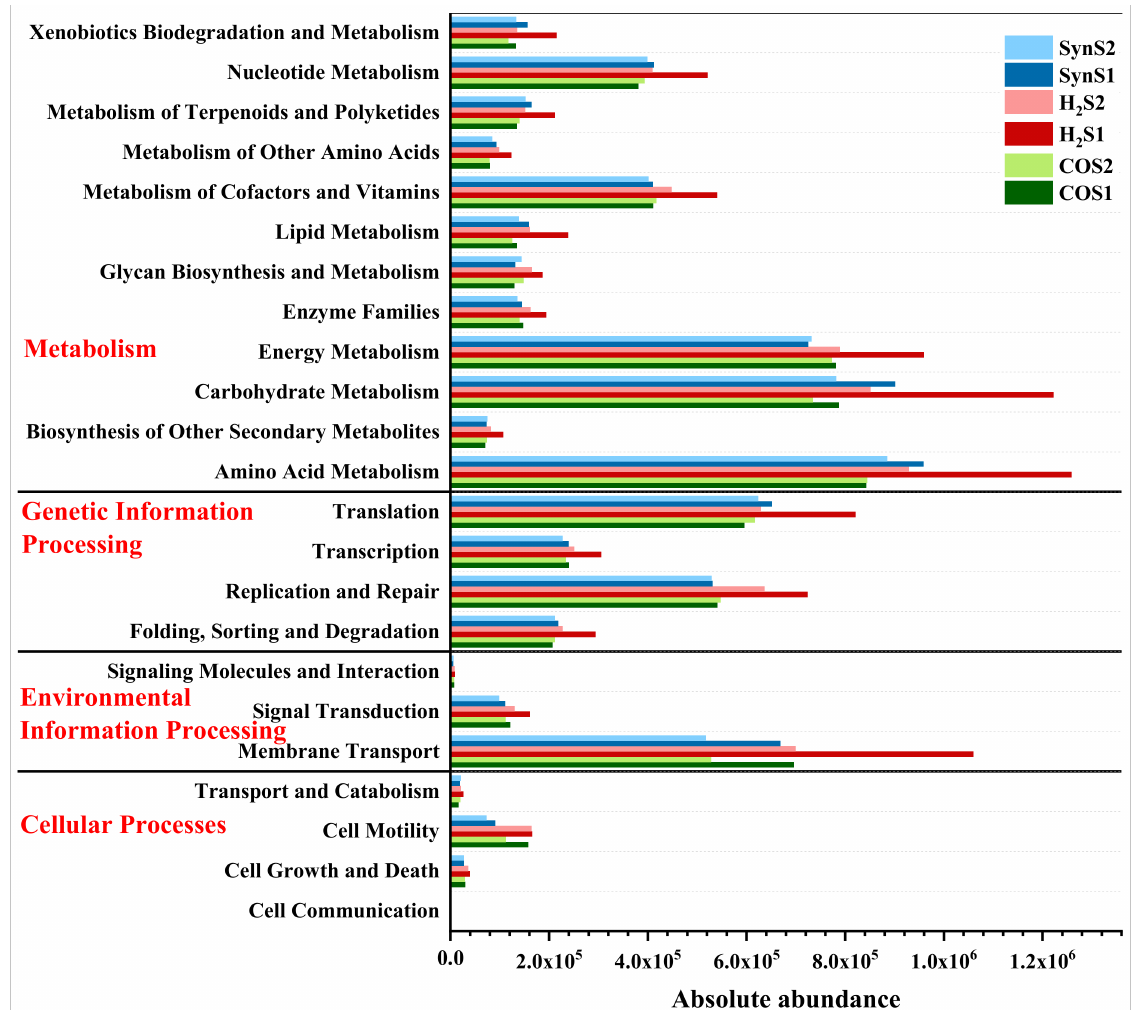
Figure 9. Absolute abundance of KEGG function classification at Level 2 under the start-up stage and the normal operation stage. (S1: Stage 1 for reactor start-up operation; S2: Stage 2 for normal reactor operation. CO: the test run was started up by feeding with 50% CO + 50% N 2 . H 2 : the test run was started up by feeding with 50% H 2 + 12.5% CO 2 + 37.5% N 2 . Syn: the test run was started up by feeding with 20% H 2 + 50% CO + 30% CO 2